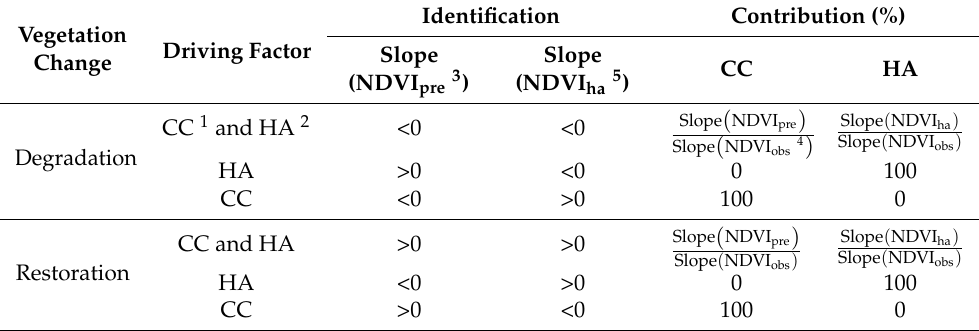
Table 2. Identification and contribution of driving factors of NDVI